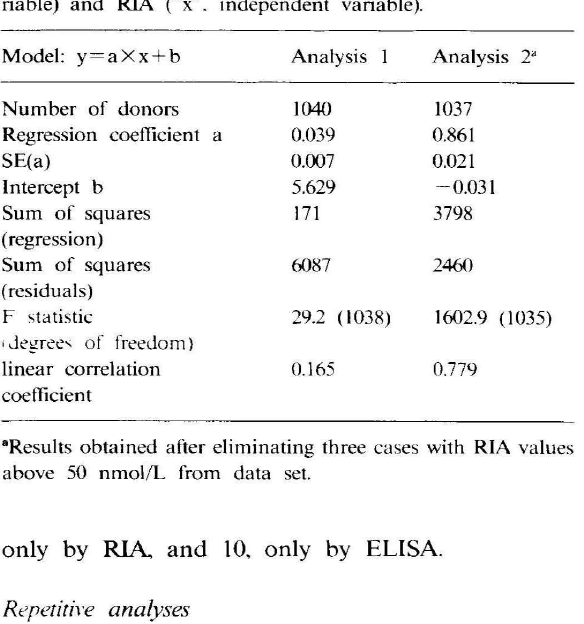
Table 2. Linear regression analysis of neopterin in sera from 1040 blood donors, determined by ELISA (y", dependent va riable) and RIA Cx". independent variable).